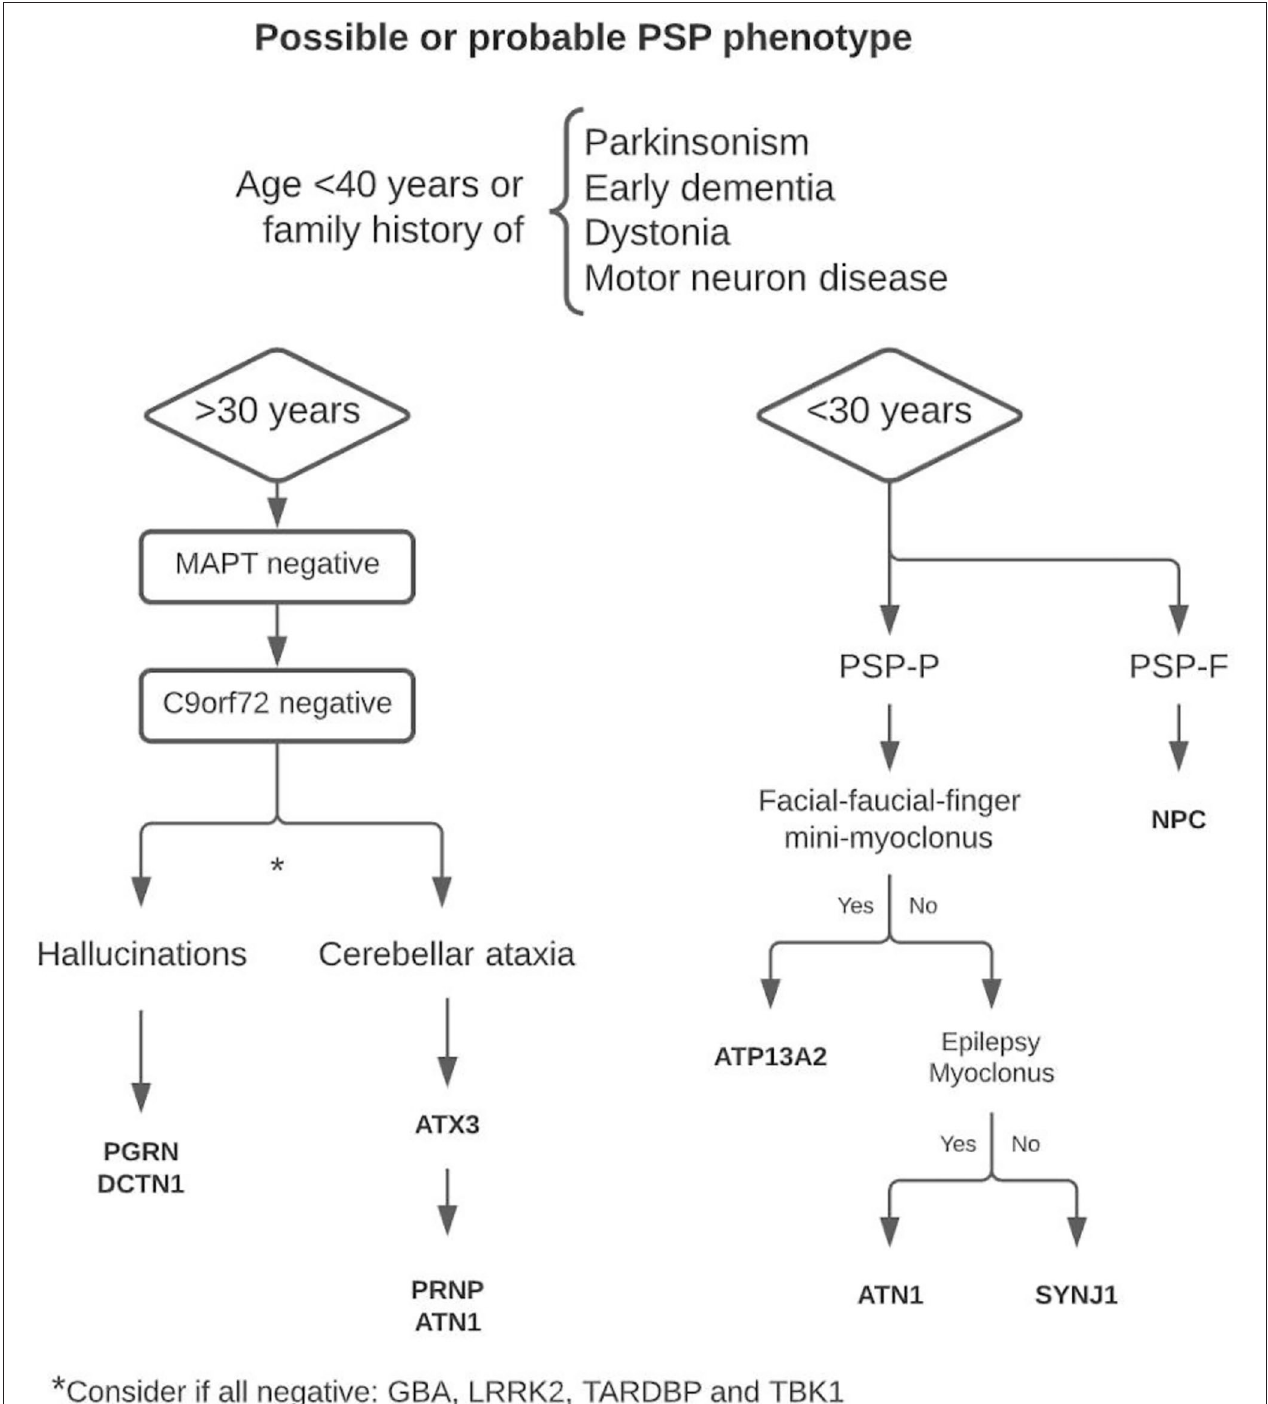
FIGURE 1 | Proposed decision algorithm for genetic diagnostics.